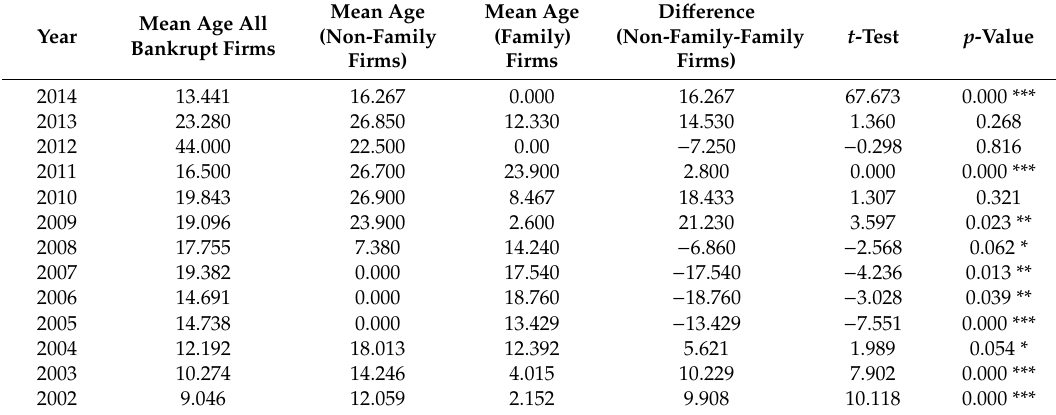
Table 7. Bankrupt Firms over the period 2014 to